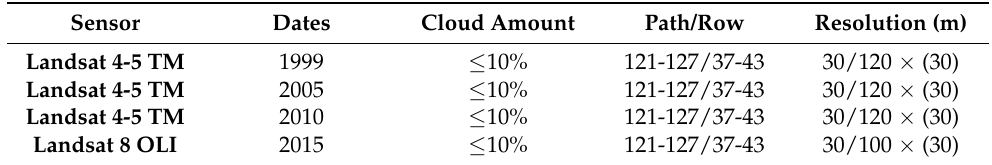
Table A1. Remote sensing data used in the